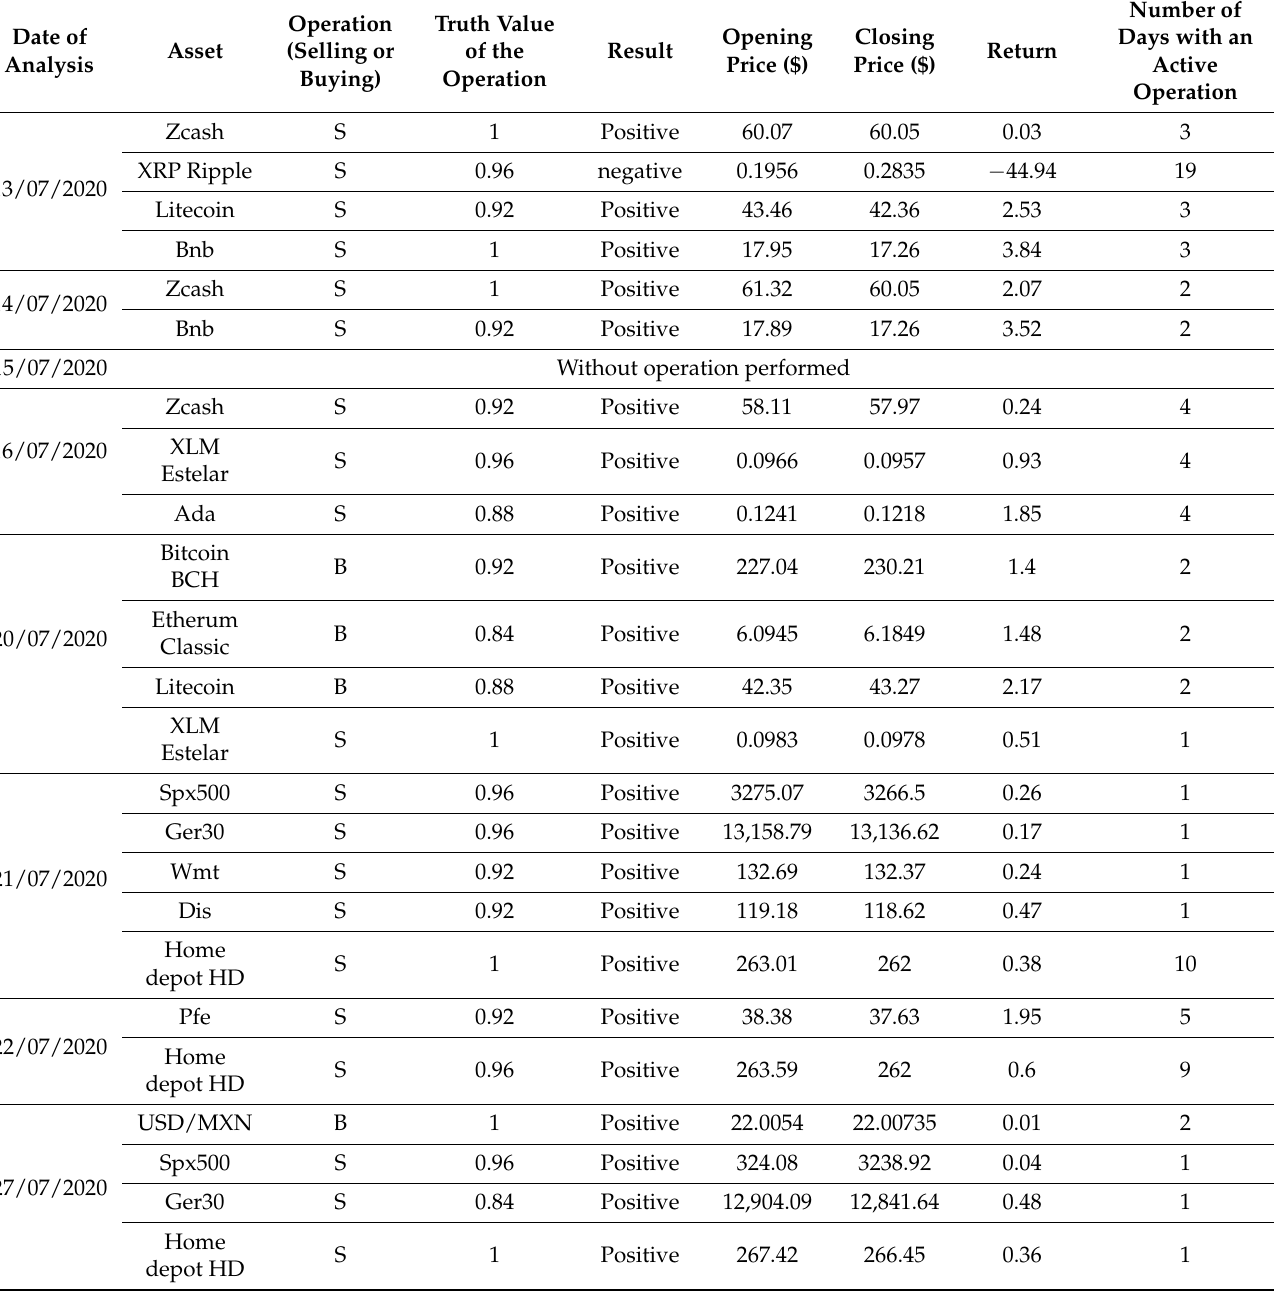
Table 1. Sample of